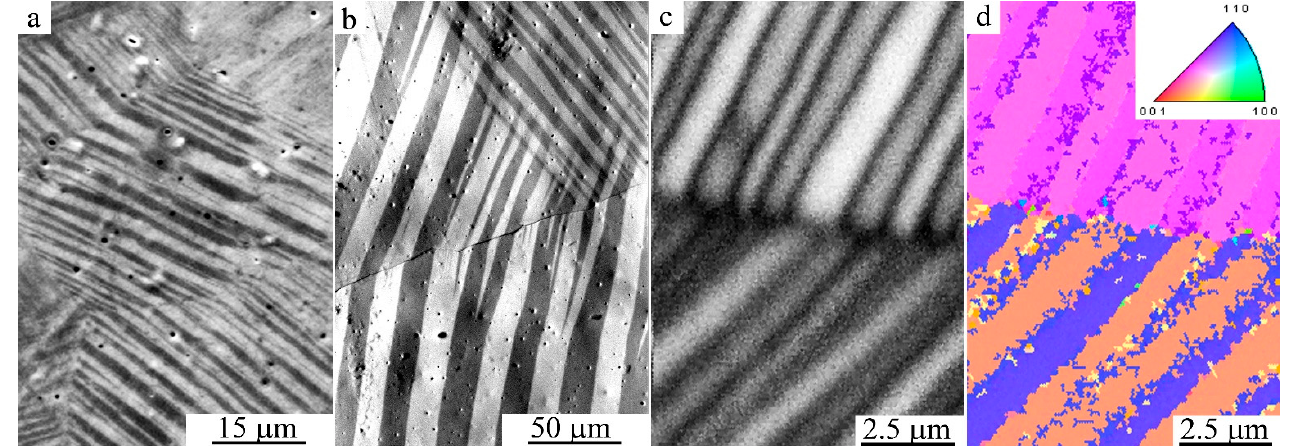
Figure 2. SEM images of ( a ) the packet microstructure of 10 M martensite in the initial cast alloy Ni 50 Mn 28.5 Ga 21.5 in secondary electrons; ( b ) magnetic domains under Lorentz microscopy, and ( c , d ) microcrystals with a thickness of ~1 micron of twin orientation according to EBSD.